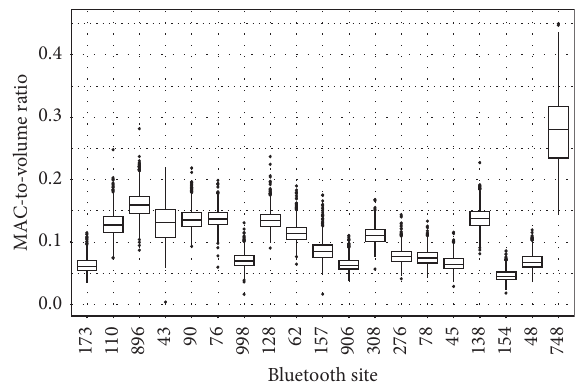
Figure 7: The box-plot of MAC-to-volume ratio of BMS